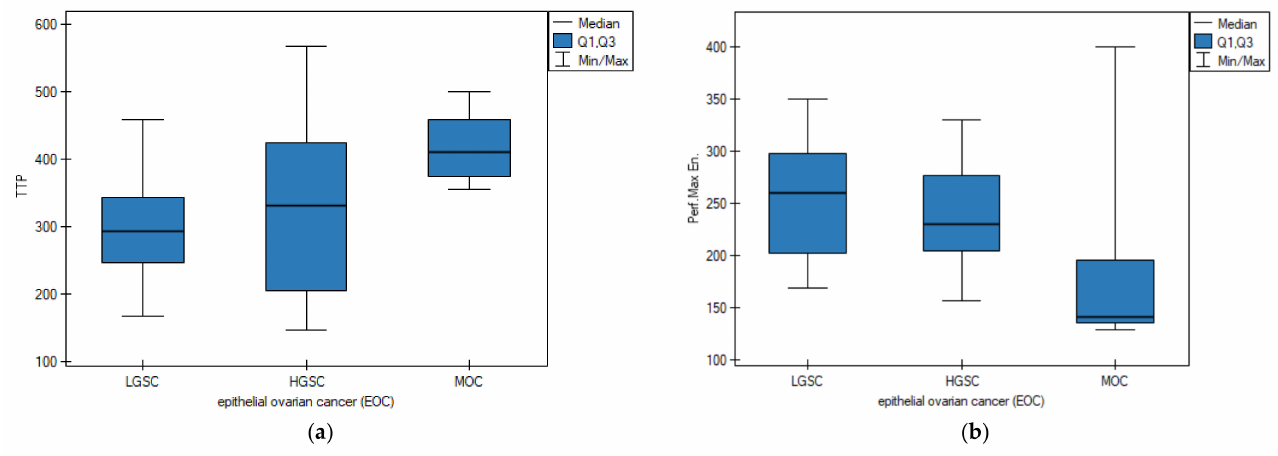
Figure 3. ( a ) Box plot of comparisons of median TTP for LGSC, HGSC and MOC patients. ( b ) Box plot of comparisons of median Perf. Max. En. for LGSC, HGSC and MOC